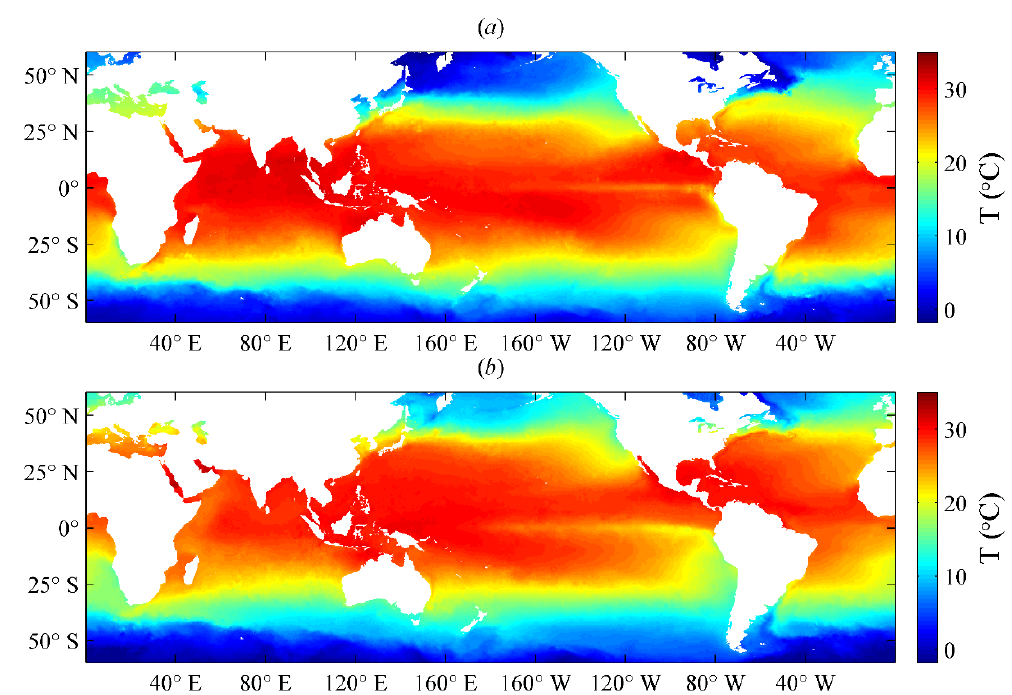
Figure 11. Daily sea surface temperature (SST) analysis results from ( a ) 1 May 2016, and ( b ) 1 October 2016, obtained by the Kalman filtering method with oriented elliptic correlation scales.